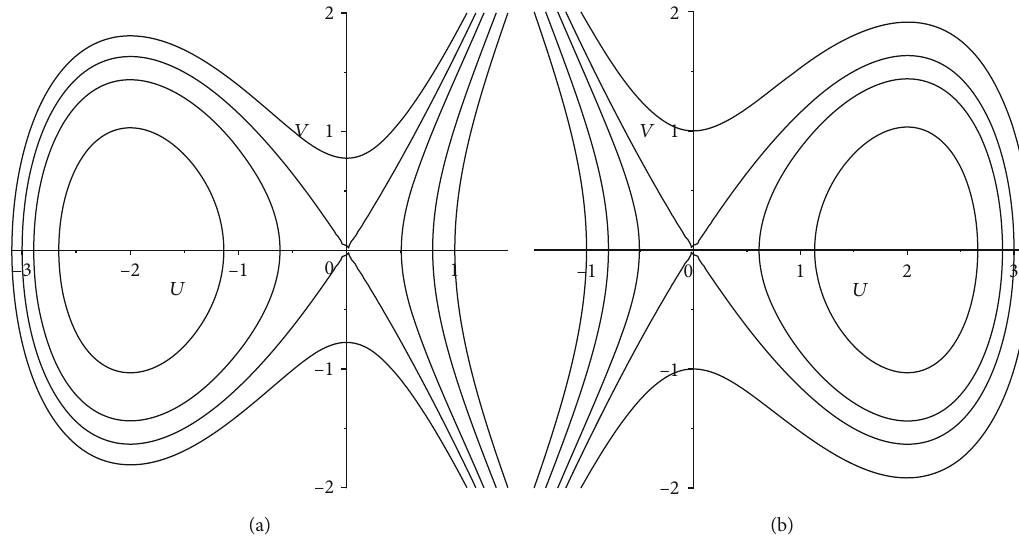
Figure 1: The phase portraits of the system (9) for B > 0 : (a) A > 0 ; (b) A < 0 .